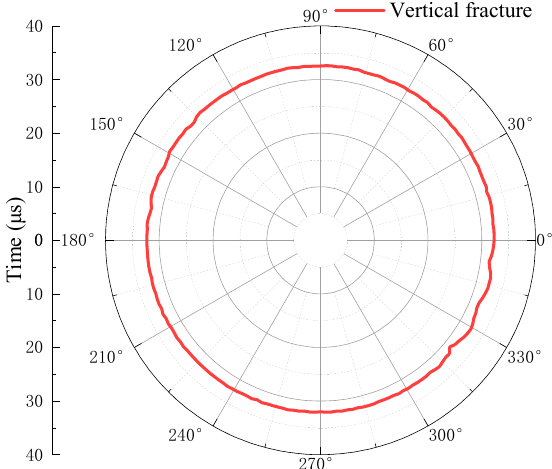
Figure 22. Echo arrival time of vertical fracture.